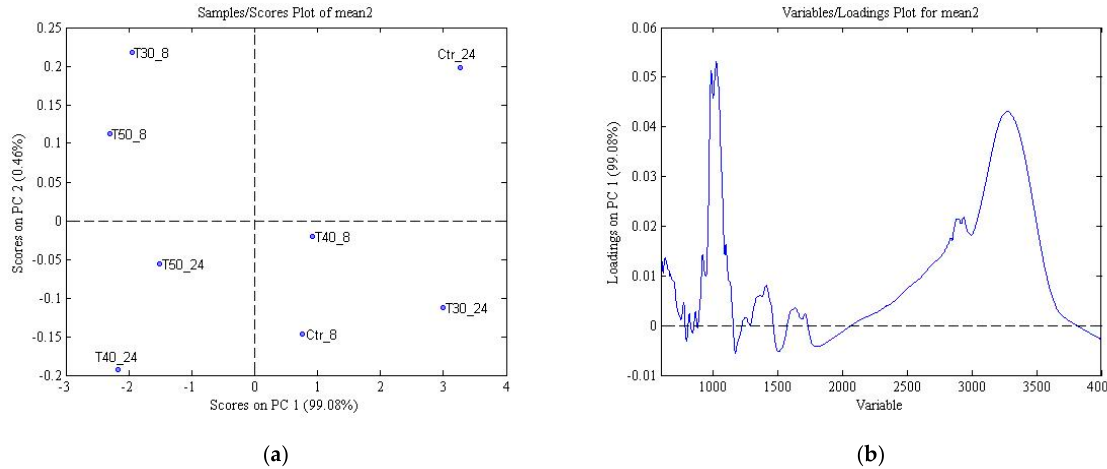
Figure 3. Principal component analysis score plot for pineapple shell FT-IR spectra of the control (Ctr) and heat-treated (T) wounded pineapple shell samples, stored at 5 ± 1 °C for 8 h (_8) and 24 h (_24). ( a ) PC1 versus scores on PC2; ( b ) loadings plot on PC1. T30_8: heat-treated at 30 °C for 15 min and stored at 5 ± 1 °C for 8 h; T30_24: heat-treated at 30 °C for 15 min and stored at 5 ± 1 °C for 24 h; T40_8: heat-treated at 40 °C for 15 min and stored at 5 ± 1 °C for 8 h; T40_24: heat-treated at 40 °C for 15 min and stored at 5 ± 1 °C for 24 h; T50_8: heat-treated at 50 °C for 15 min and stored at 5 ± 1 °C for 8 h; T50_24: heat-treated at 50 °C for 15 min and stored at 5 ± 1 °C for 24 h.